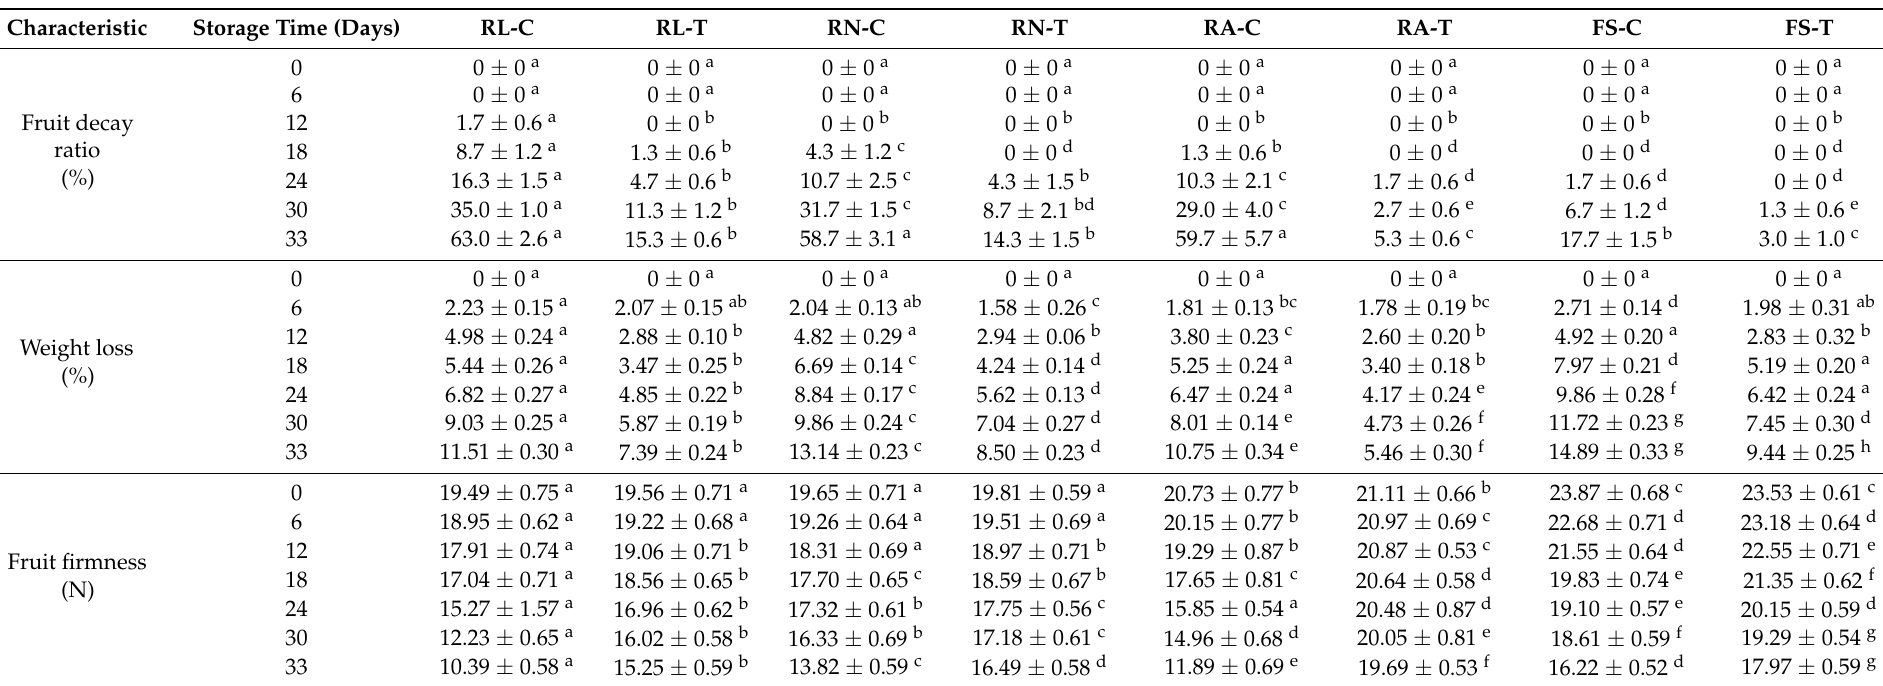
Table 3. Mean values for quality parameters: fruit decay ratio, weight loss, and fruit firmness at harvest (0) and after 6, 12, 18, 24, 30, and 33 days storage for control and AA-CaCl 2 -CMCS-GL coated fruit.